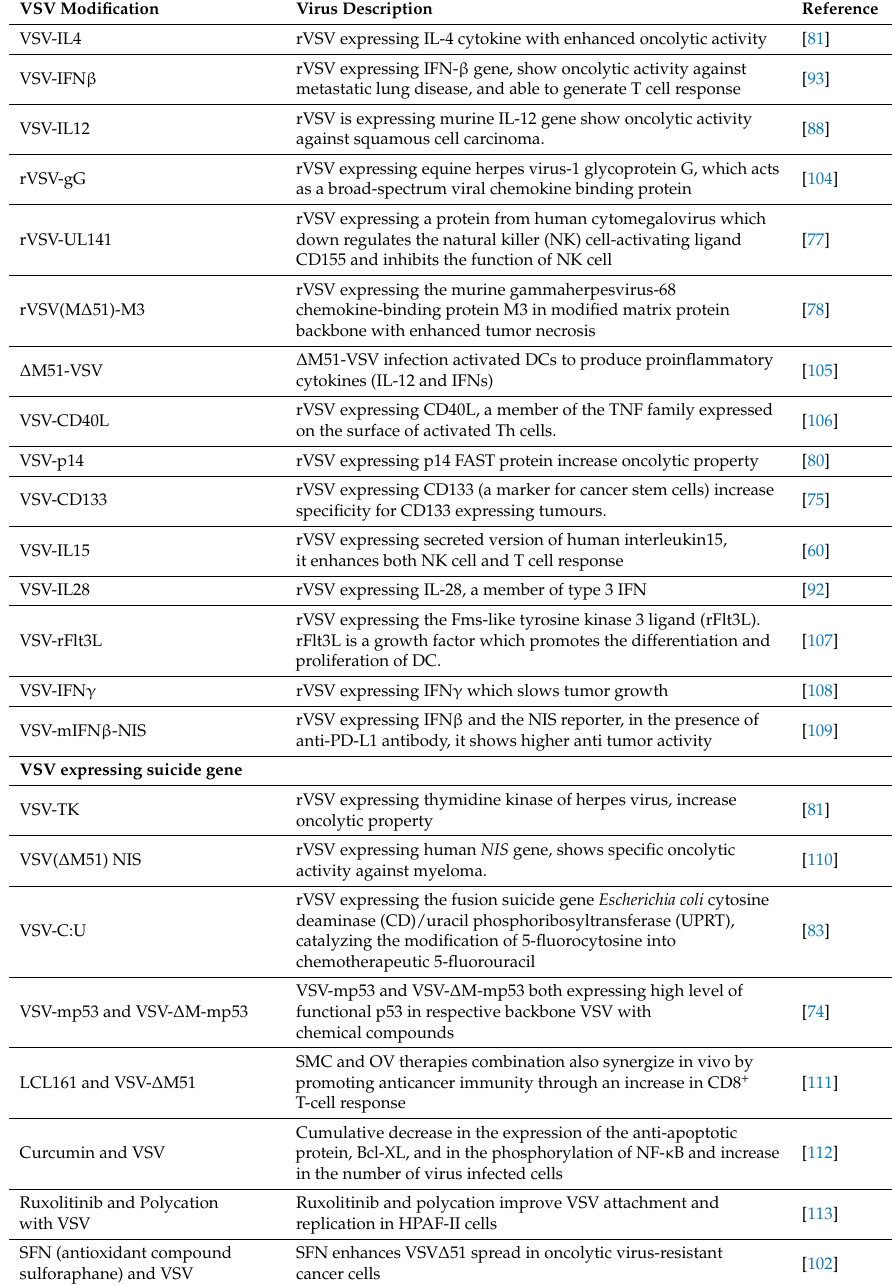
Table 1. List of potential recombinant vesicular stomatitis viruses with created for oncotherapy application. VSV